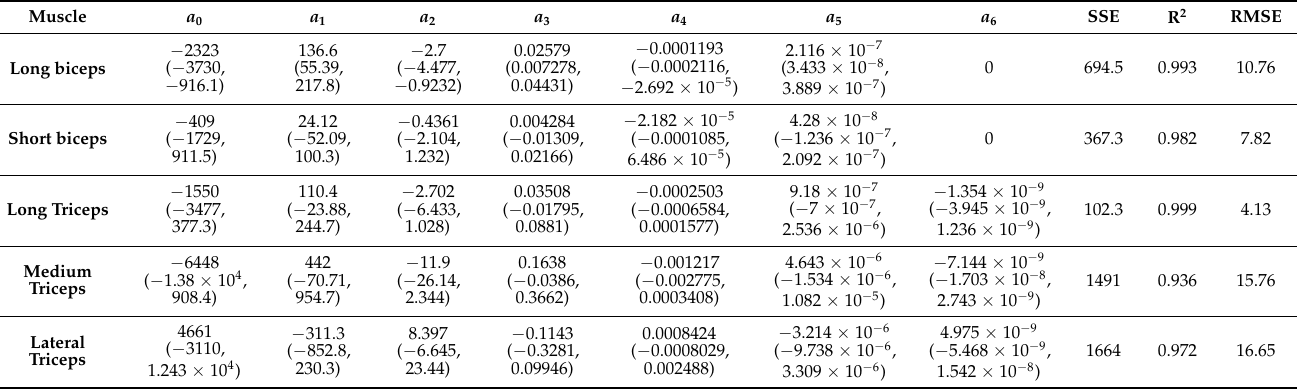
Table 3. The equations developed as polynomial curves of grade 6th, based on the general formulation of Equation (4), has the following constant values for each muscle